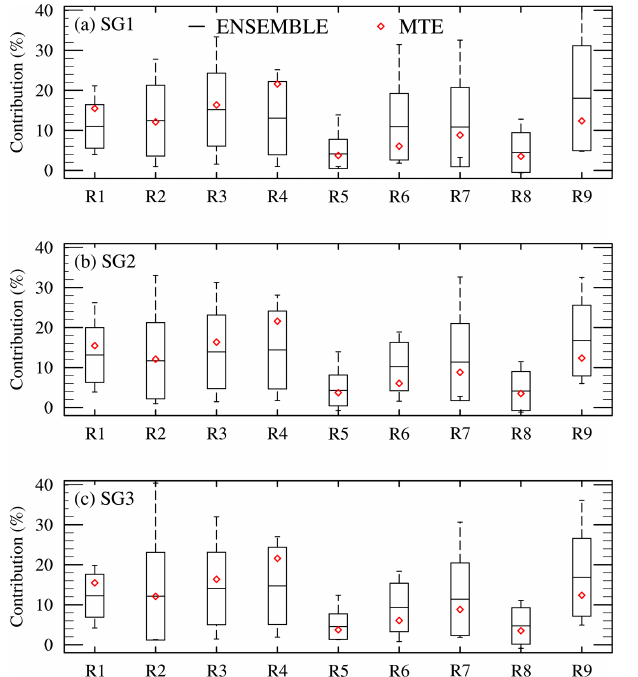
Figure 5. The relative contributions of each subregion to the inter- annual variability (IAV) of China’s GPP. Boxplots indicate the dis- tributions of the 12 MsTMIP models. Horizontal lines at top, middle and bottom in the boxplots represent the maximum, ensemble mean and minimum of multi-model simulations, respectively, whereas the box indicates 1 standard deviation. All the results in this figure are averaged between 1981–2010 for the MsTMIP models and 1982– 2010 for the